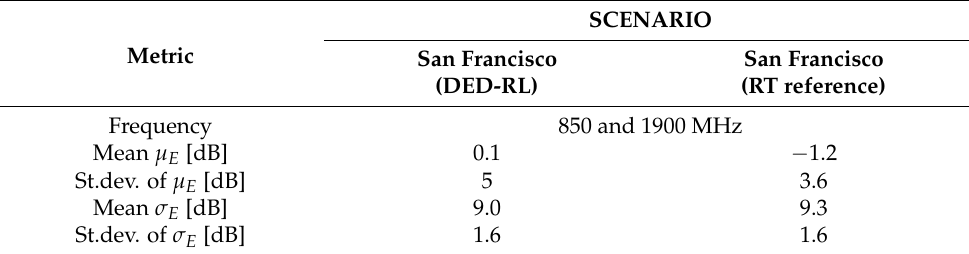
Table 2. Global statistics for the RL simulations vs. measurements in the San Francisco scenario. Global statistics of RT in the same scenario are reported as a reference.